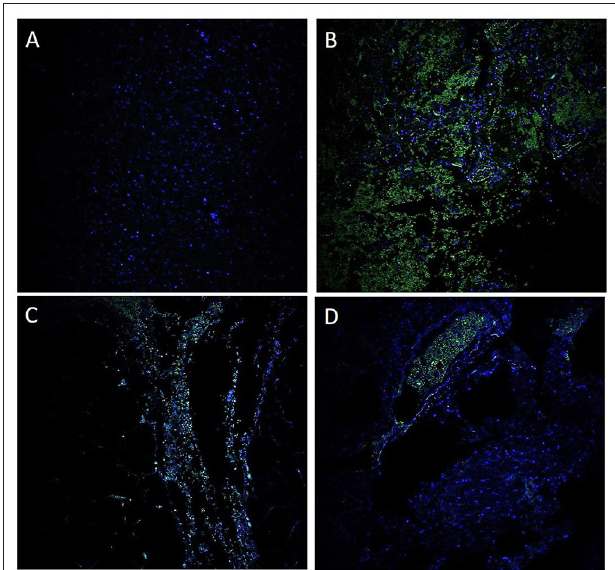
FIGURE 6 | Immunofluorescence for antibody against SARS-CoV-2 nucleocapsid protein. A negative control using a probe targeting DapB (Bacillus subtilis strain) did not detect any staining (A) ; a positive control demonstrated strong positive staining in sections probed with the housekeeping gene (B) . These findings suggest that the GI tract is infected with SARS-CoV-2 (C) . A unique observation in our case study is the presence of the virus within the blood vessels (D)